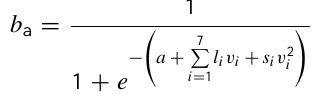
Model variables ( v ) Corr. coeff. Constant term Linear coeff. Squared coeff. Linear coeff. Squared coeff. in single var. in single var. in single var. in single var. in final in final model model ( a ) model ( l ) model ( s ) model ( l ) model ( s